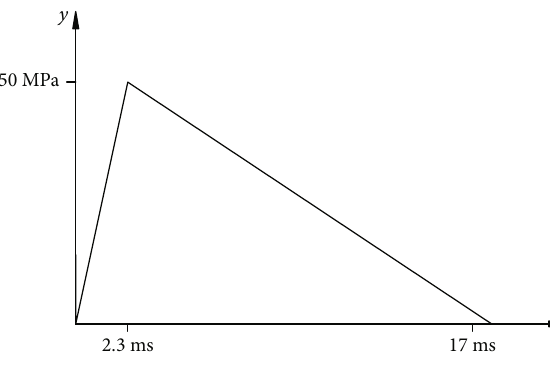
Figure 2: Time history curve of explosion load.